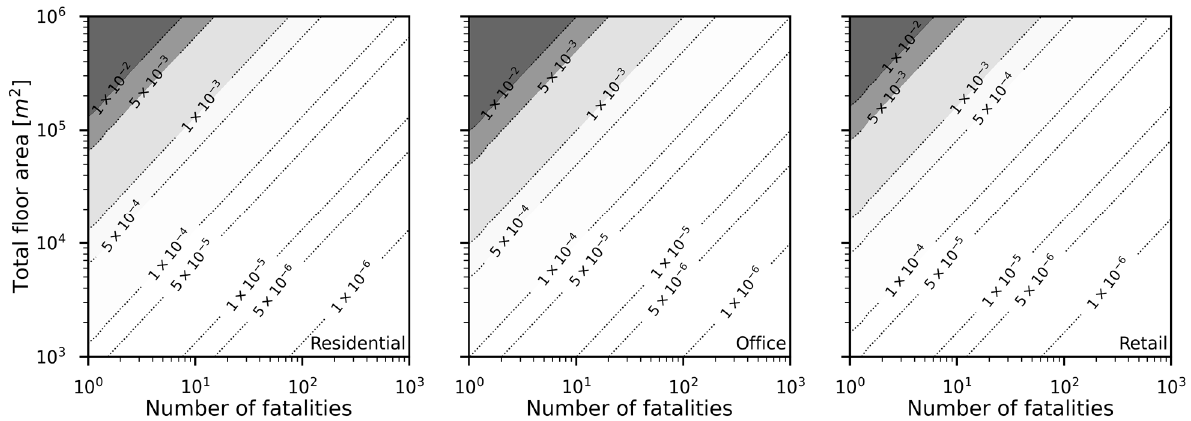
Figure 5. Acceptable failure probability in function of the number of fatalities and floor area, for residential, office and retail use.